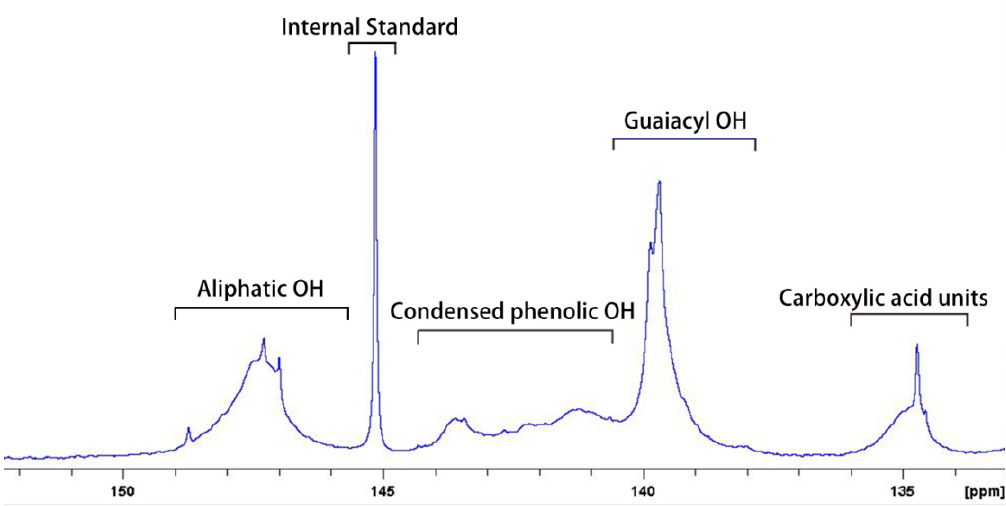
Figure 2. 31 P NMR spectra of the purified lignin.